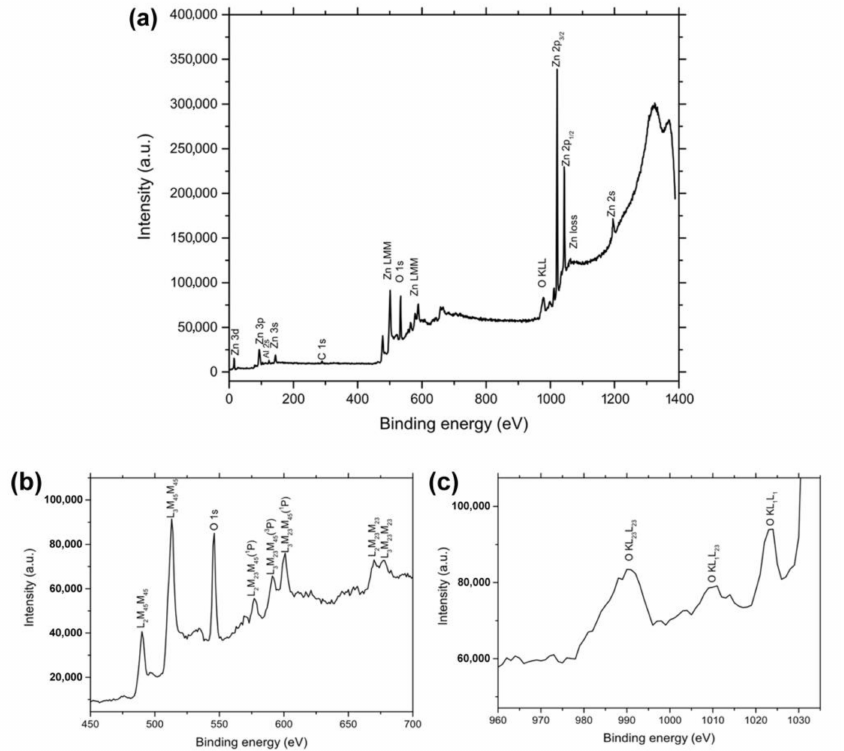
Figure 1. XPS and AES spectra for sample 650_18 excited with Al K( α ) radiation with 1486.6 eV of energy: ( a ) XPS widescan; ( b ) Auger lines of zinc; ( c ) Auger lines of oxygen. AES peaks follow IUPAC notation in which the transition between the initial and final states occurs